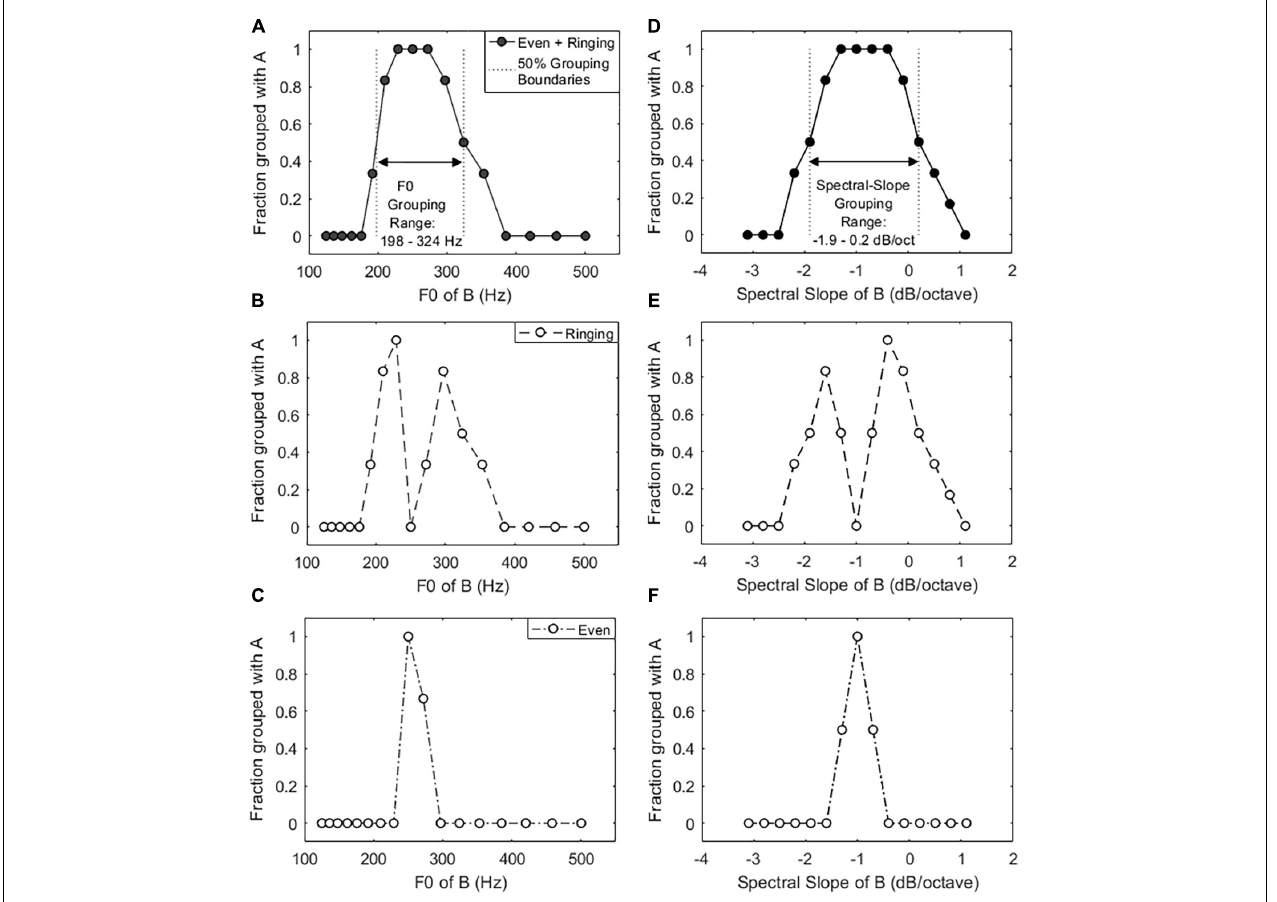
FIGURE 2 | Example F0 grouping function (A) and spectral slope grouping function (D) calculated from the proportion of both the “ringing” responses (B,E) and “even” responses (C,F) (i.e., A = B + C and D = E + F ). Vertical dotted lines in (A,D) indicate the 50% boundaries of the grouping